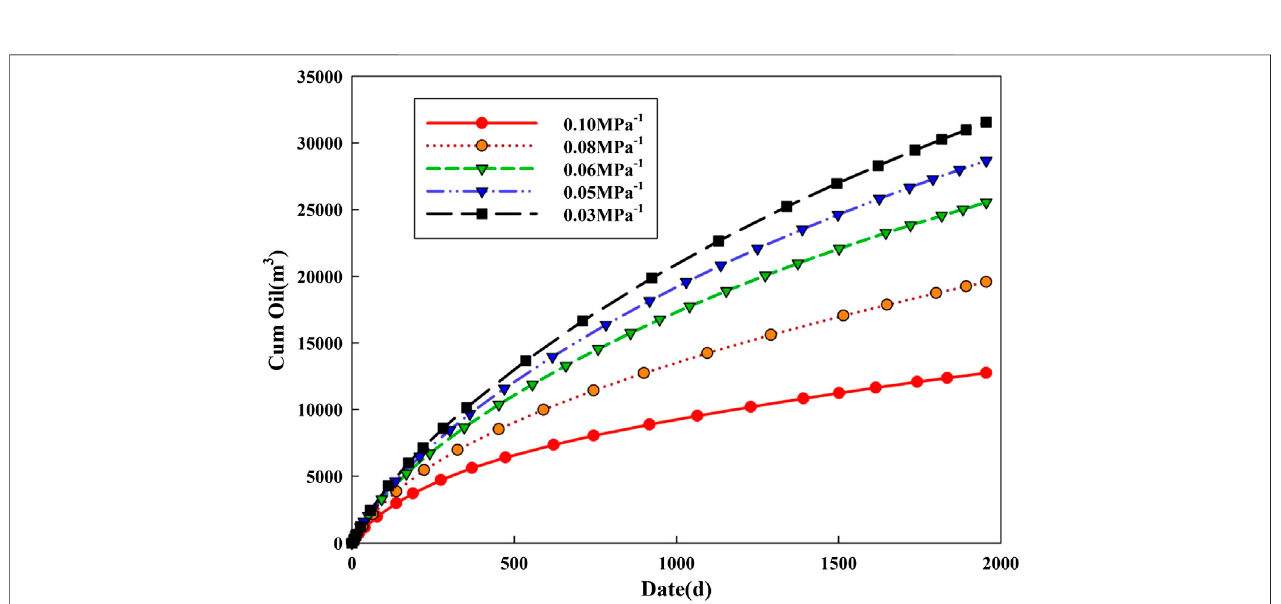
FIGURE 7 | Daily oil production curve of different stress sensitivity coef fi cient.